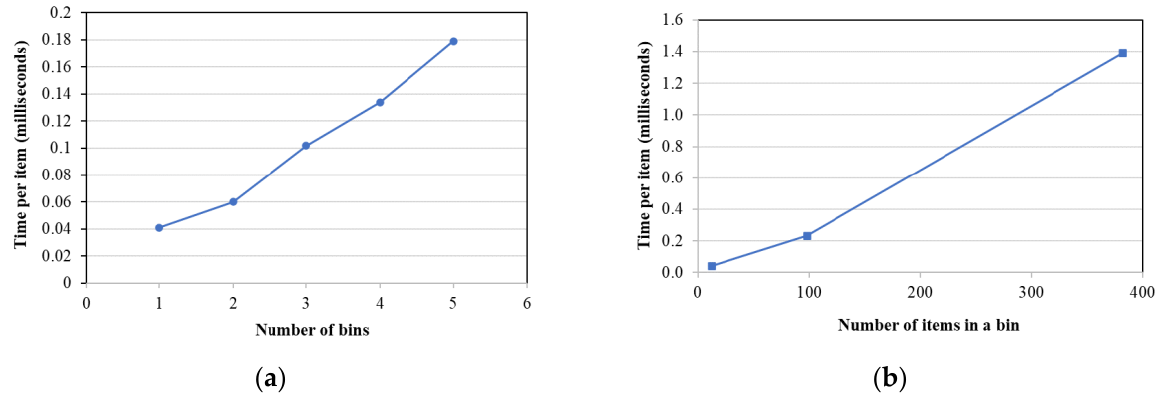
Figure 7. The time performance of the proposed algorithm: ( a ) the average time vs. number of bins; ( b ) the average time vs. the average number of items that can be put into a bin.